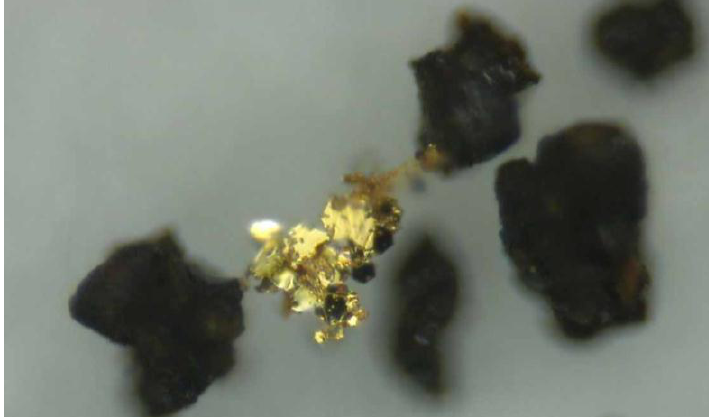
Figure 27. Image of filter cake after the adsorption of gold(III) on PP gel observed by an optical microscope. Brilliant yellow is the particle of metallic gold while black materials are particles of PP